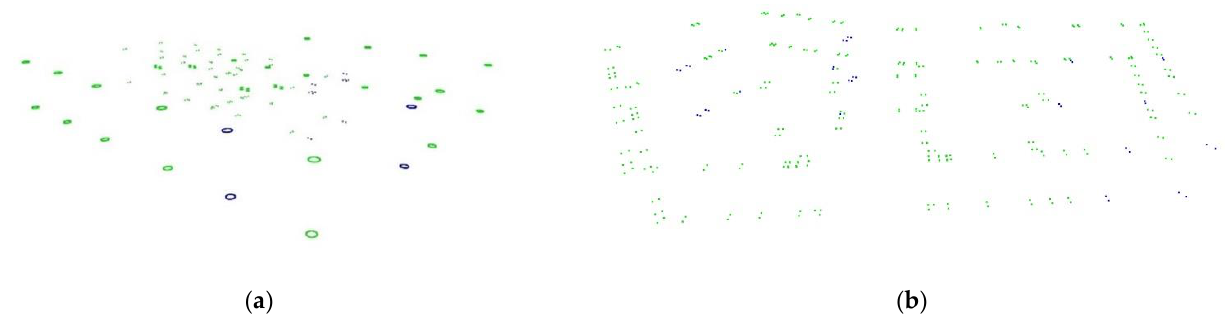
( c ) Figure 14. Data output in occluded and noisy environment: ( a ) some of the columns have shifted and duplicated, the surface of some objects is not fully scanned and is, therefore, incomplete, ( b ) an obstacle